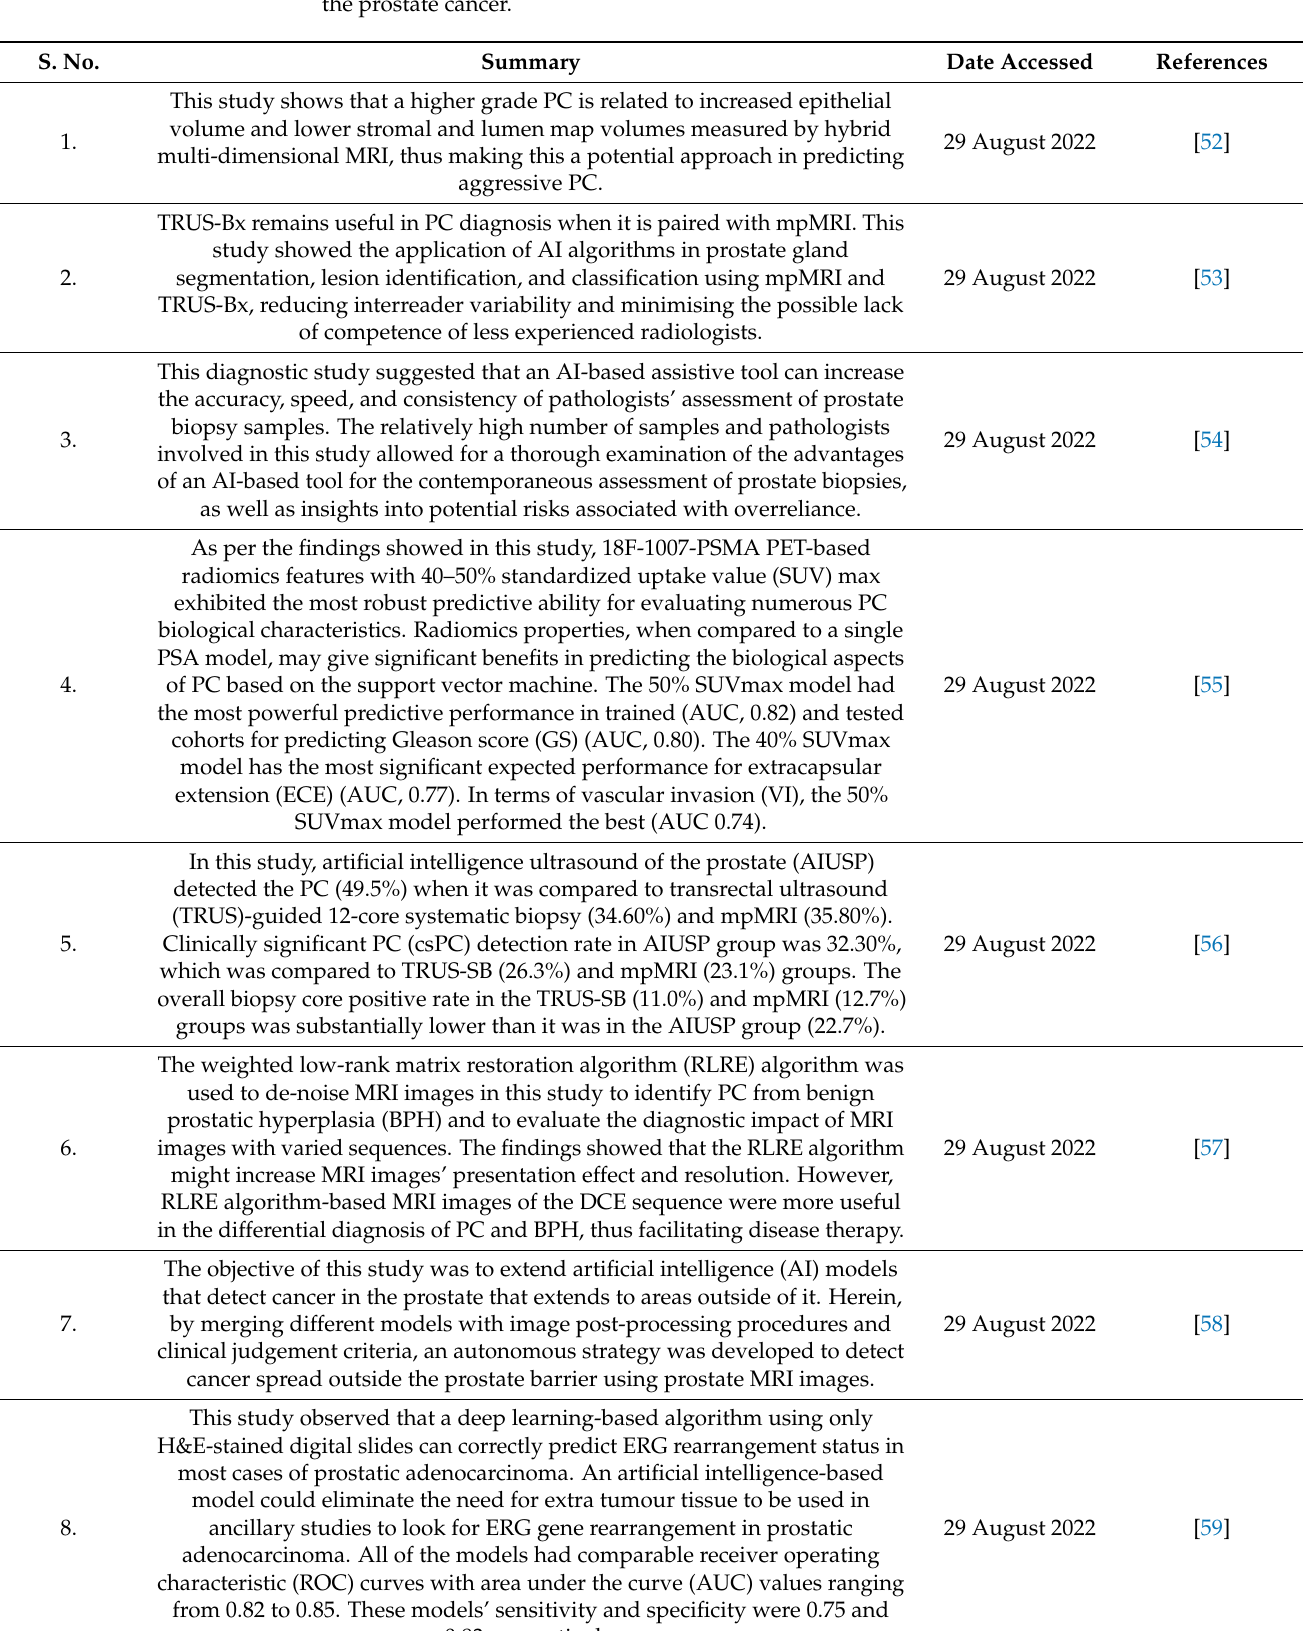
Table 3. Summary of studies that mentioned the application of AI/machine learning in diagnosing the prostate